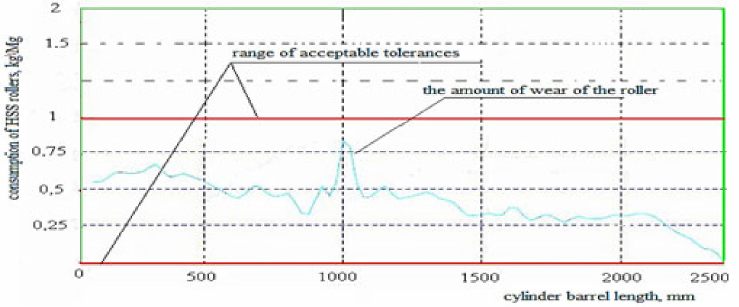
Figure 6. Graph volume of local consumption for HSS rolling type. Source: own, based on [38]. Table 6. Map of defects for HSS type rolling.